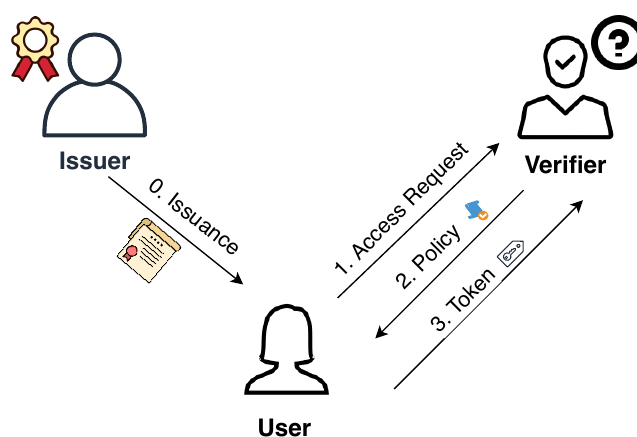
Figure 1. Privacy attribute-based credentials (p-ABC)